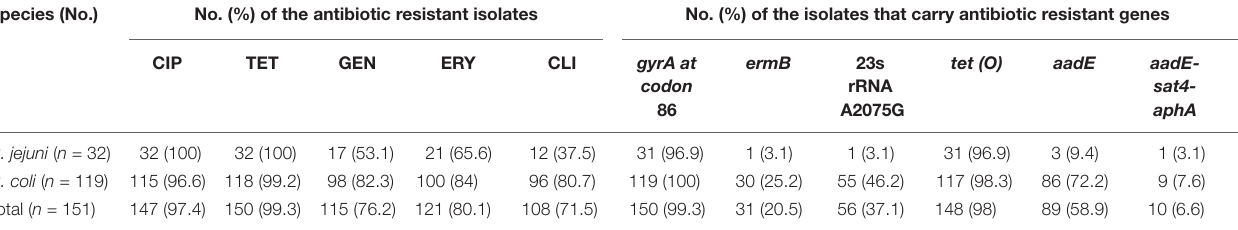
TABLE 3 | The 151 multidrug-resistant Campylobacter isolates and the presence/mutant of the associated antibiotic resistant genes. Species